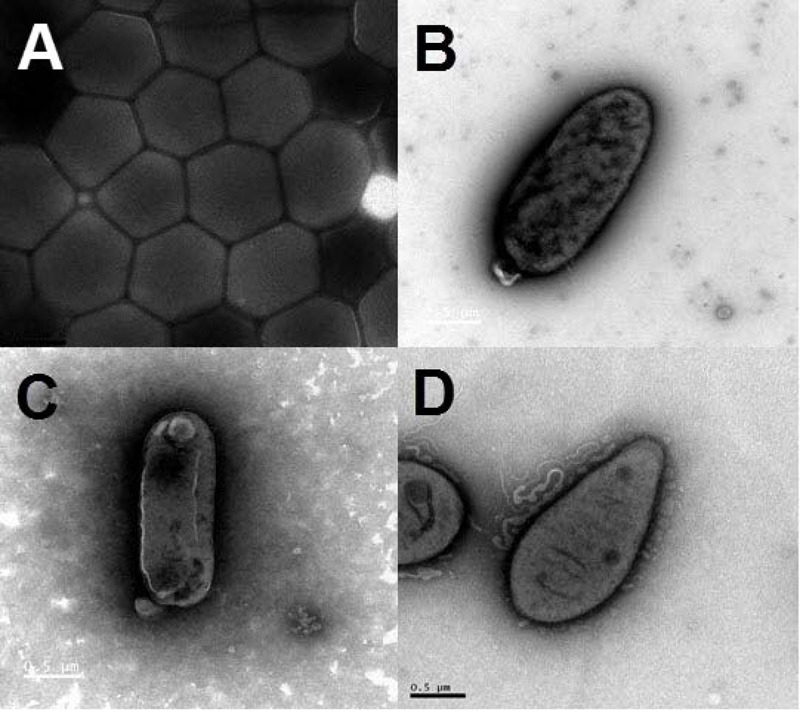
Transmission electron micrograph images of representative strains isolated from the shallow-sea hydrothermal system. (A) Strain JLT9 belonging to the genus of Serinicoccus within Actinobacteria, (B) Strain T28 belonging to the genus of Maribacter within Flavobacteriia, (C) Strain JL3646 belonging to the genus of Marivivens within Alphaproteobacteria, (D) Strain P5 belonging to the genus of Rhodovulum within Alphaproteobacteria.